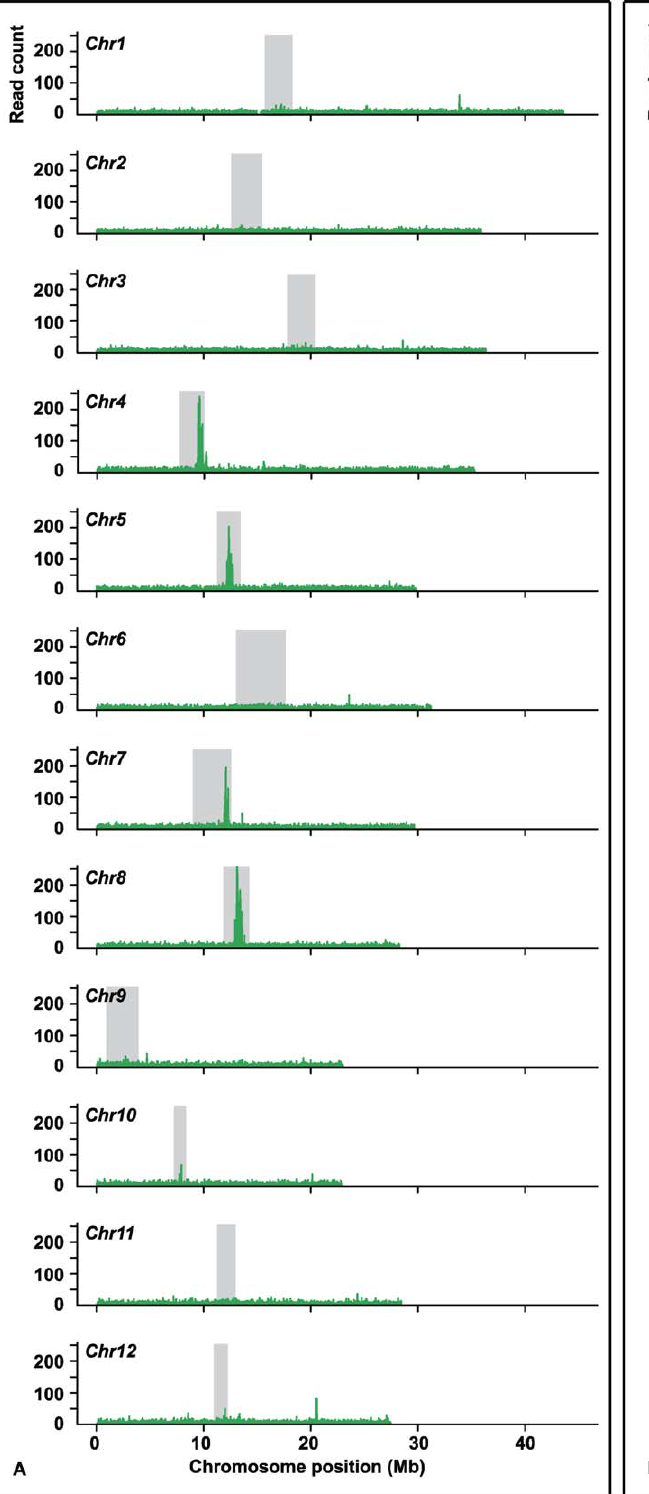
Figure 1. Plot of ChIP-Seq Sequence Reads along Individual Rice Chromosomes The region corresponding to the crossover-suppressed domain in each centromere is shadowed in gray. (A) The window size is 20 kb, spaced every 10 kb. Strong enrichment of sequence reads was observed in Cen4 , Cen5 , Cen7 , and Cen8 ; less significant enrichment was also detected in Cen10 . (B) For each centromere, 2 Mb of flanking sequence from each side of the crossover-suppressed domain was used as a control, except the short-arm side of Cen9 , in which all of the 993-kb sequence was analyzed. The read density was calculated to represent the number of reads in each 20 kb based on the mappable sequence, as specified in Materials and Methods. The inferred boundary of the CENH3-binding domain is indicated by vertical red